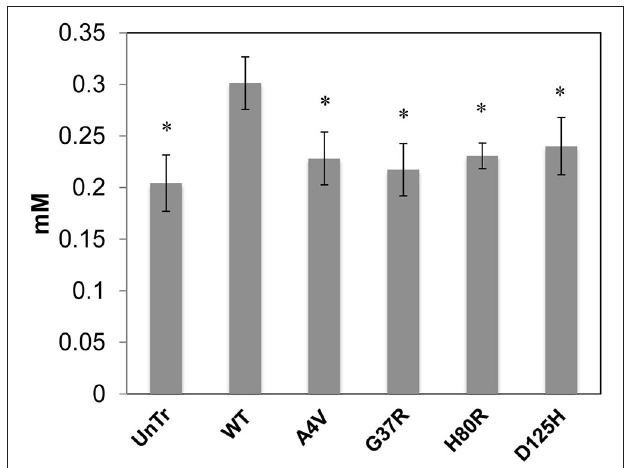
FIGURE 2 | Bar graph of intracellular copper levels (excluding the nucleus) for SOD1-YFP cells . Concentrations are in mM. The WT cells contained the highest level of copper in comparison to the cells overexpressing mutations in SOD1 and untransfected cells. All cells overexpressing mutant SOD1 had significantly higher copper content than the untransfected cells. * indicates significantly less than WT cells with p < 0.001.